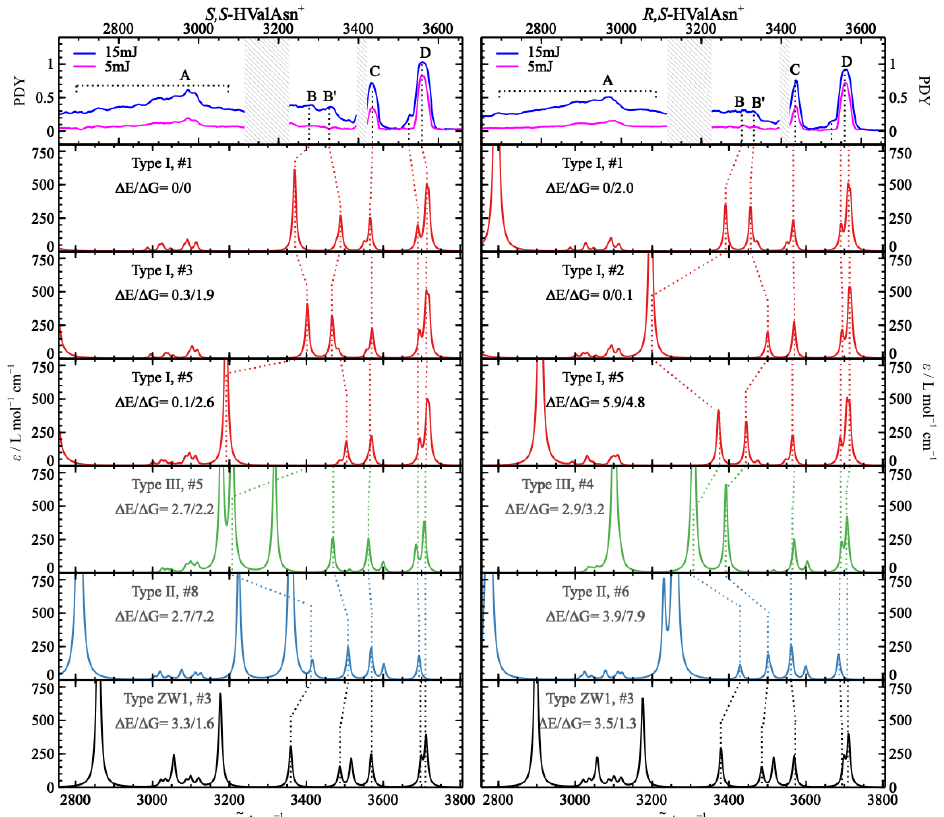
Figure 7. Top panel: experimental IRMPD spectra of S , S - and R , S -HValAsn + dimers under two laser energies. The two laser “blind” regions mentioned in the experimental section are indicated by the shaded areas. Lower panels: theoretical IR spectra of the most stable isomers of Type I (red), Type II (blue), Type III (green), and ZW (black). The relative electronic energy (ΔE) and Gibbs free energy (ΔG) values of respective isomers are given in units of kJ mol −1 . The theoretical IR bands correspond to the same (similar) vibrational motions and are connected with dashed lines which in turn connect to the experimental bands to indicate the assignment.